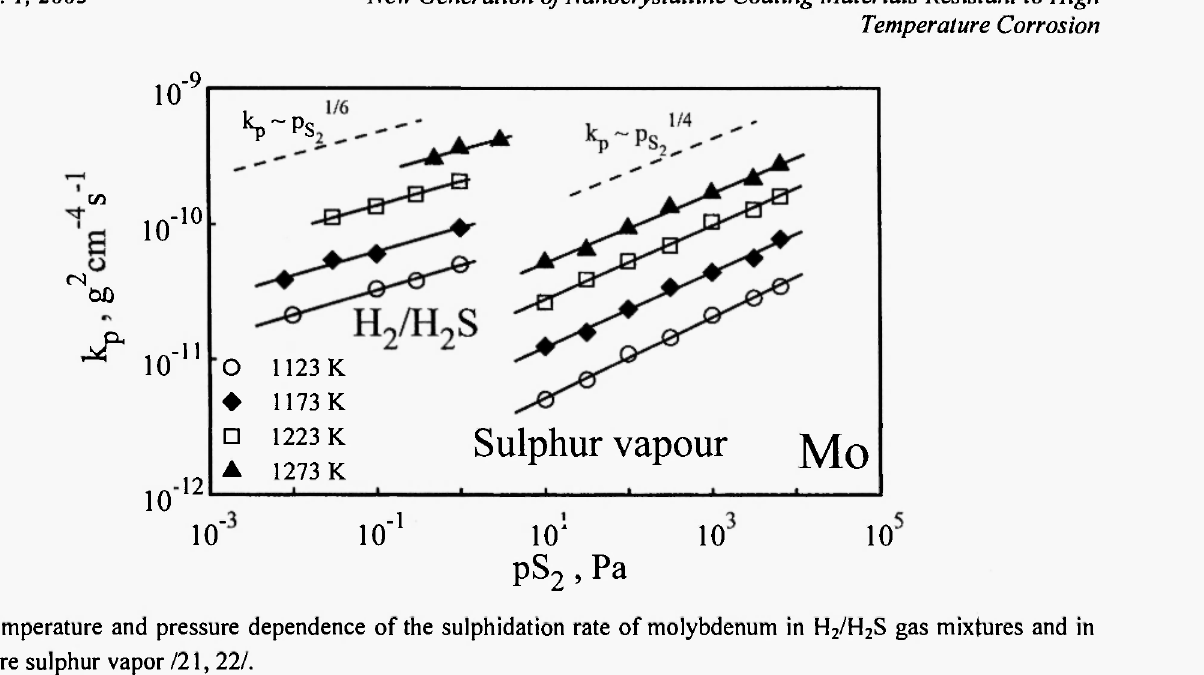
Fig. 9: Temperature and pressure dependence of the sulphidation rate of molybdenum in H 2 /H 2 S gas mixtures and in pure sulphur vapor /21,